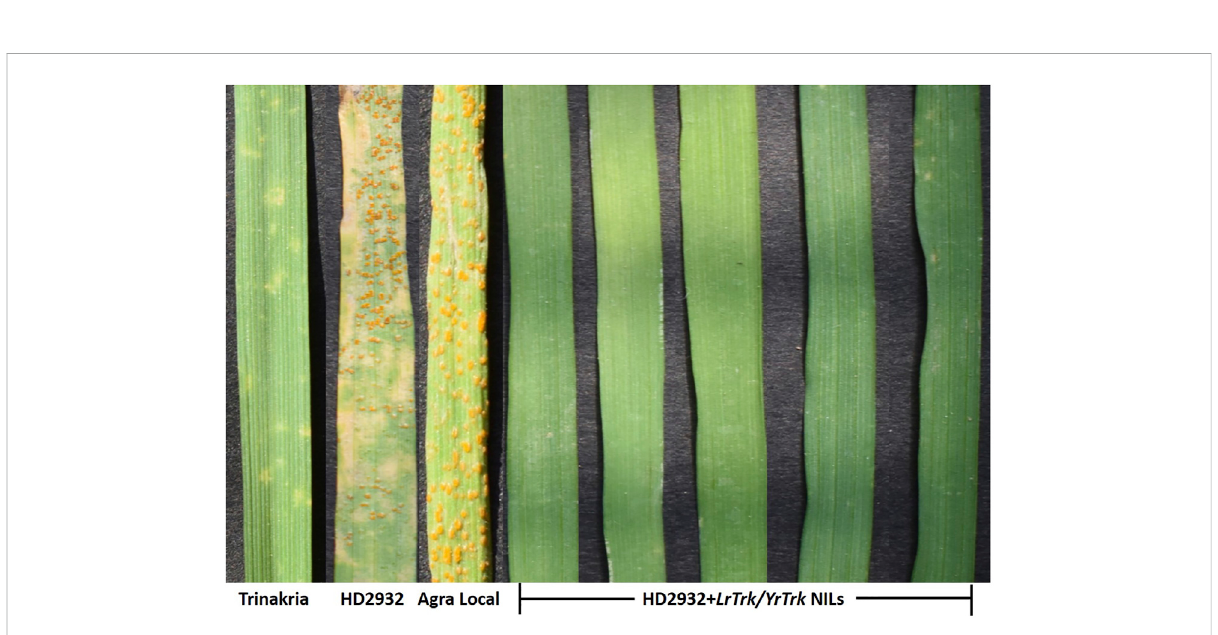
FIGURE 4 Phenotyping of parents, Trinakria and HD2932, susceptible check Agra Local, and NILs of HD2932 carrying LrTrk/YrTrk with stripe rust pathotype